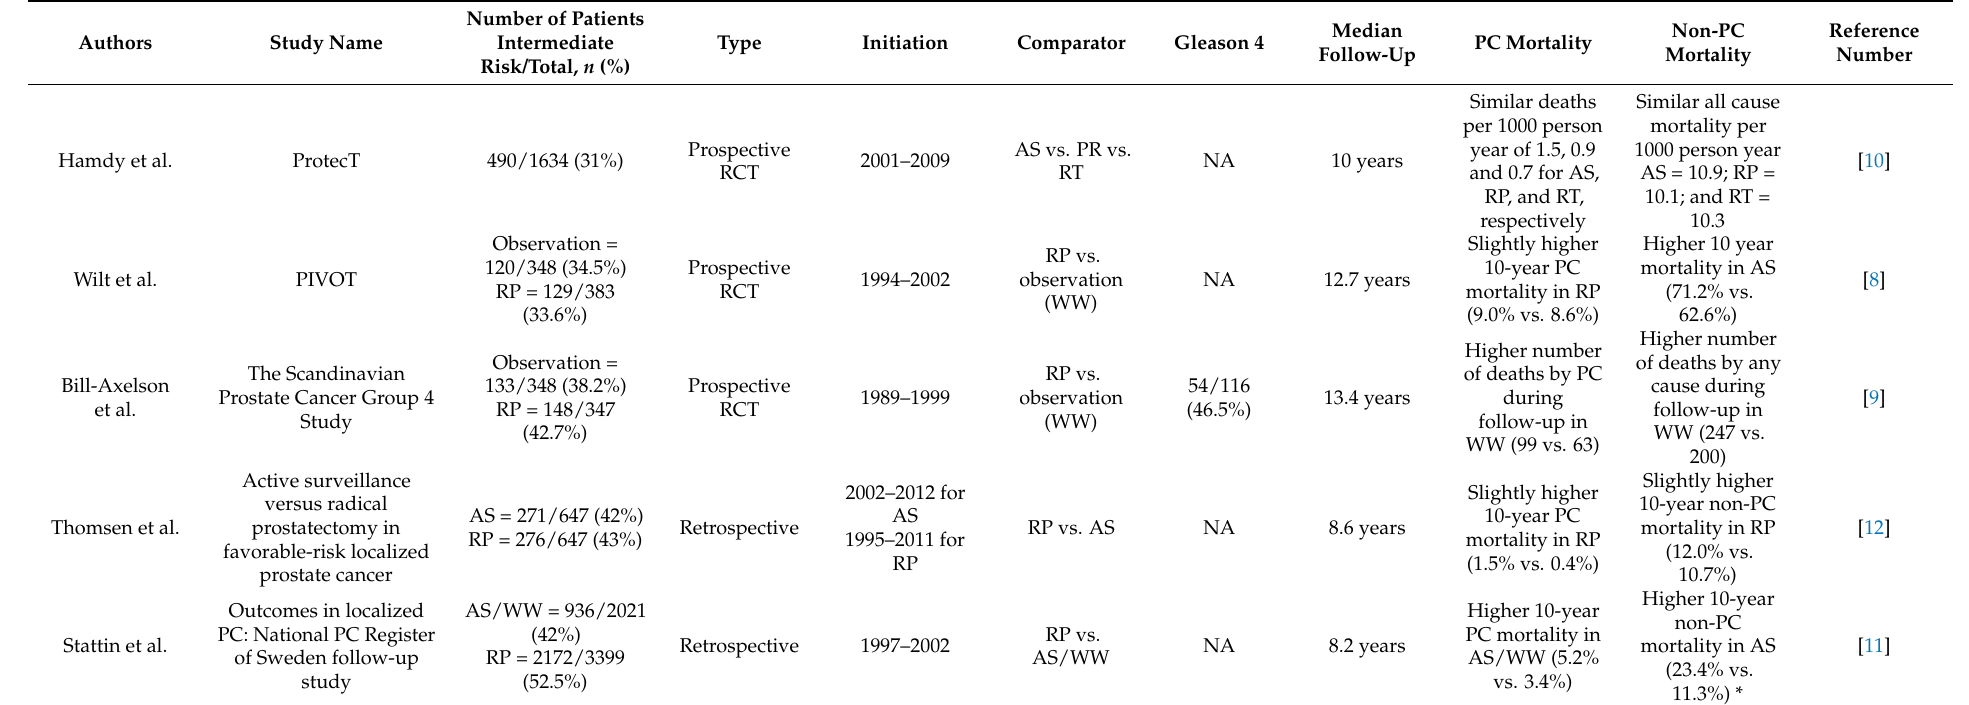
Table 1. Active surveillance versus other active treatment in localized